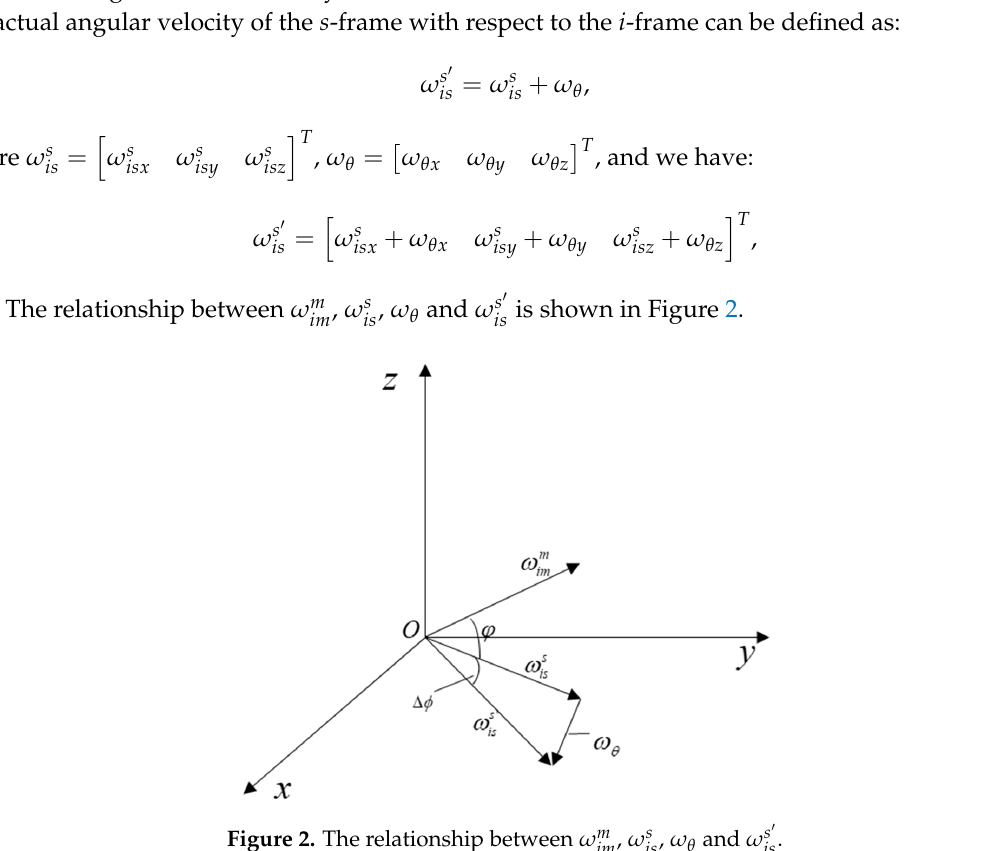
, ω s , ω θ and ω s (cid:48) . im is is